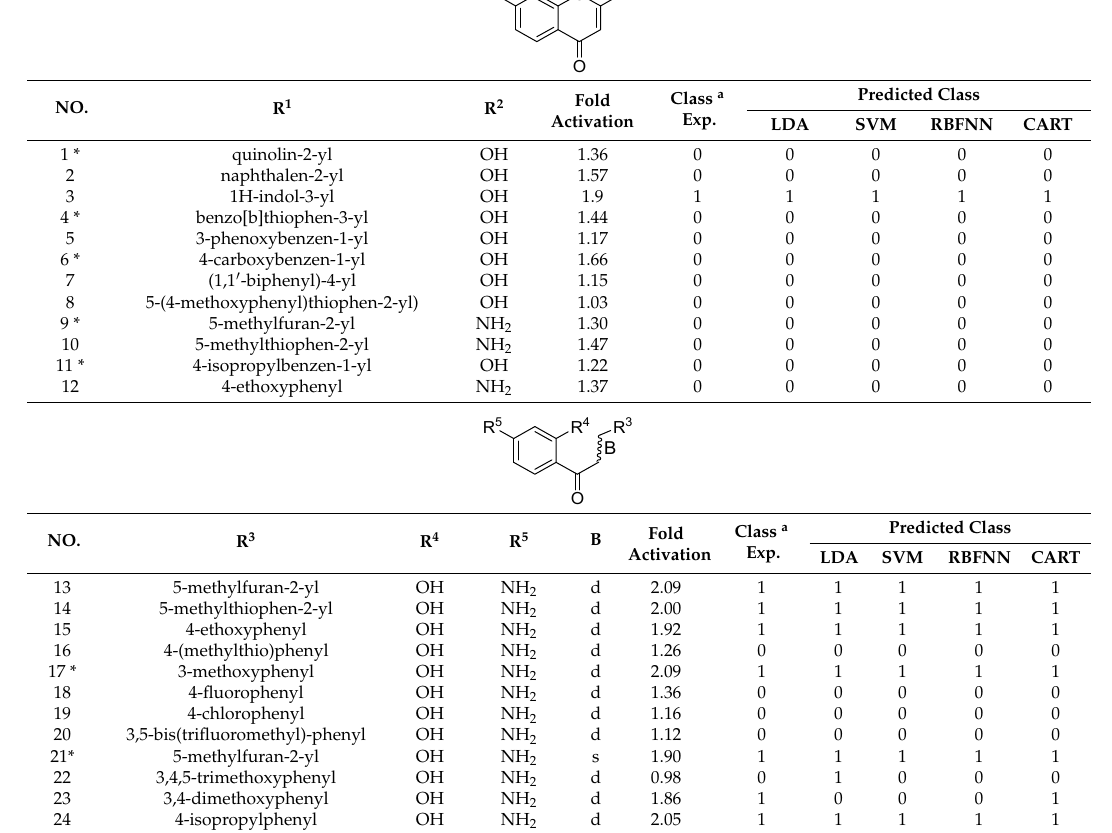
Table 3. Structures and classifications of flavonoids-based ABCA1 up-regulators in QSAR modeling.